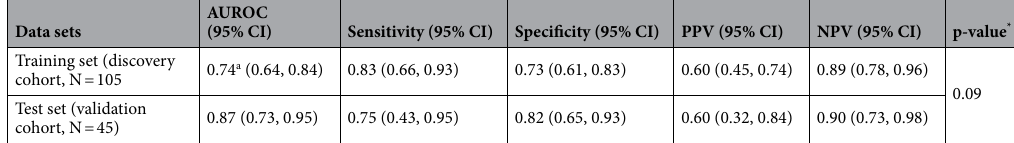
Table 1). Peritumoral-rim radiomics interrogates and potentially quantifies the heterogeneity across the inter- face between the periphery of tumor and its environment; Gabor filters are the edge detectors that capture the orientation-sensitive information. Our results suggest that the peritumoral-rim of MMR-D ECs demonstrates higher heterogeneity compared to the peritumoral-rim of CN-low-like and CN-high-like tumors. Integrated radiomic‑clinical machine learning classifier can identify TMB‑H tumors.